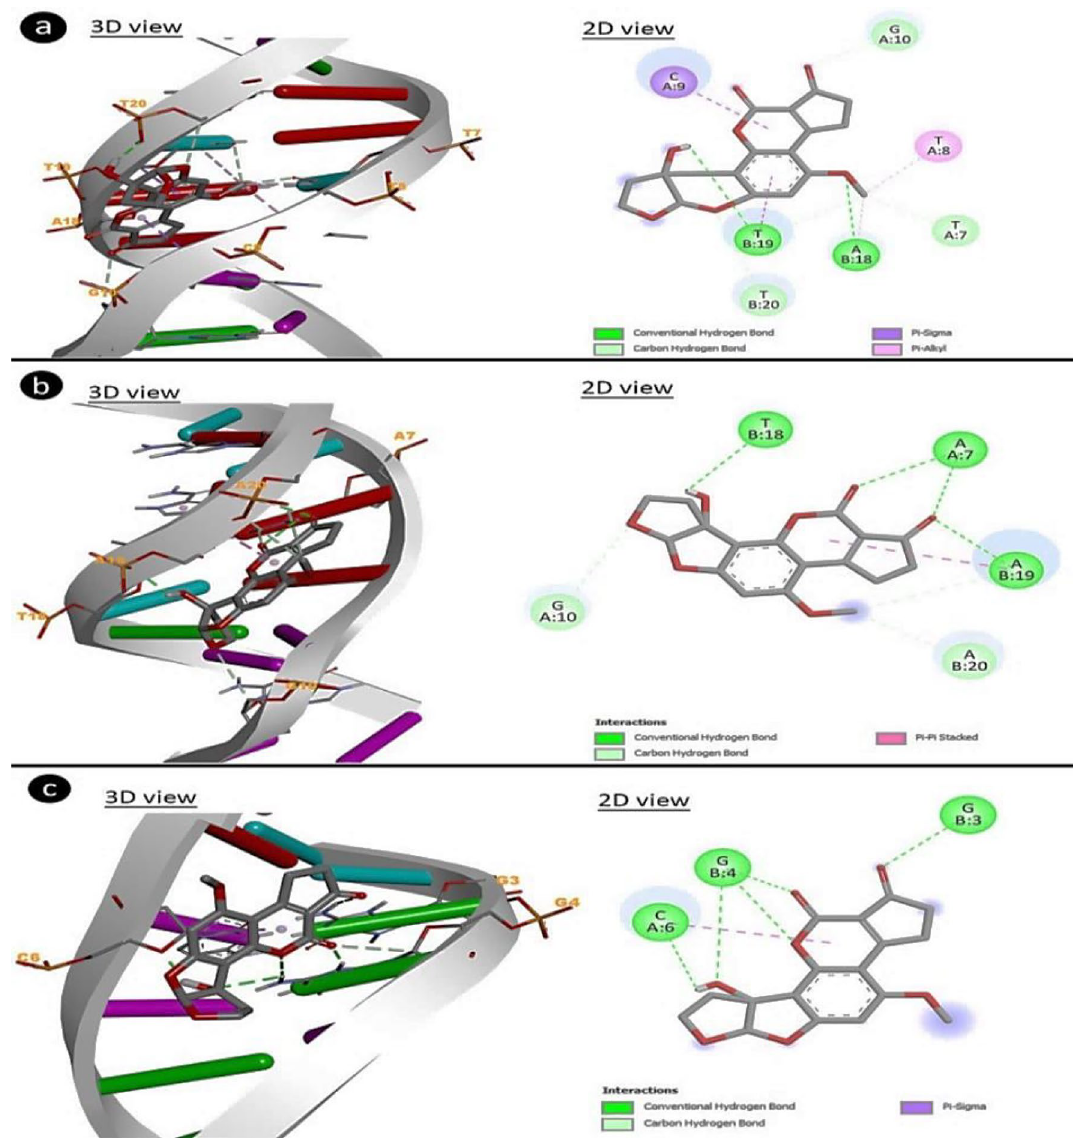
Figure 6. Molecular docking of AFM 2 and DNA sequence. 1BNA ( a ), 195D ( b ), 1CP8( c